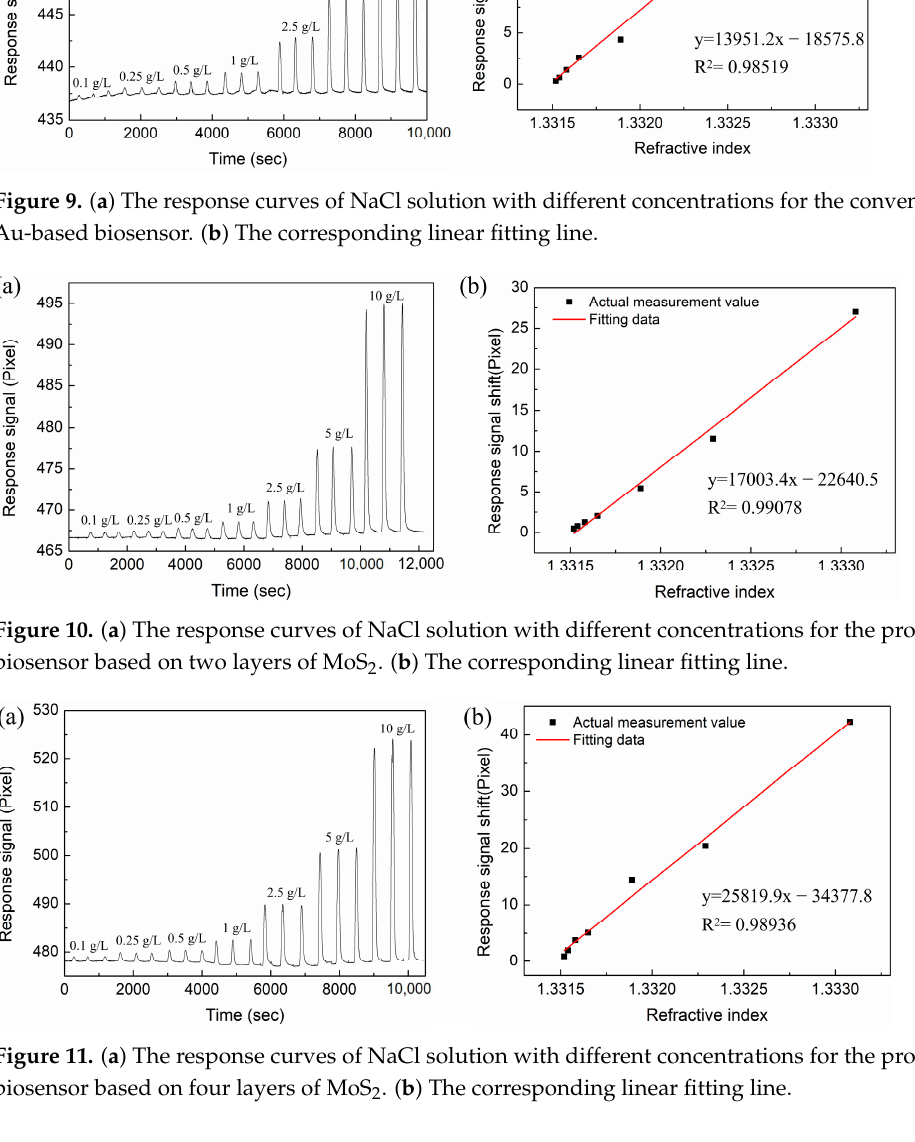
Figure 12. ( a ) The response curves of NaCl solution with different concentrations for the proposed biosensor based on six layers of MoS 2 . ( b ) The corresponding linear fitting line. 3.4. Okadaic Acid Detection Experiment 3.4.1. Fabrication of SPR Immunosensor The surface of graphene has abundant functional groups, which can be covalently bound to antigen or antibody molecules. For the pretreatment of the graphene-based SPR- sensing chip, the chip was rinsed thoroughly with plenty of water, and dried with nitro- gen. Then, the carboxyl group of graphene was activated by NHS/EDC mixture solution (M:M = 4:1, v:v = 1:1) for 30 min, followed by washing in plenty of water. Afterwards, the OA-BSA conjugate (1 mg/mL) was dissolved in PBS buffer and was dropped onto the chip surface and incubated for 1 h. Finally, a 1 mol/L ethanolamine solution (pH 8.5) was used to block the nonspecific interaction on the biosensor surface.